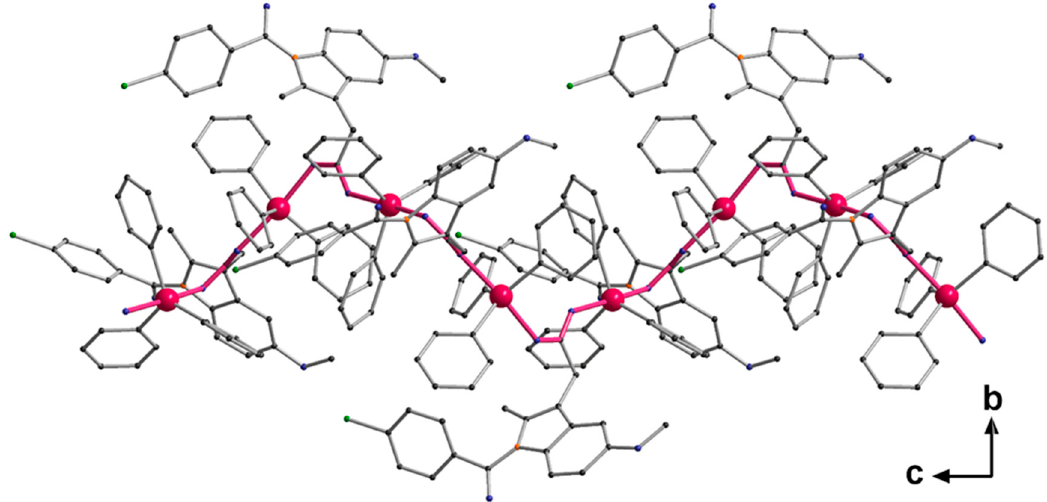
Figure 3. Helical chain structure of [Ph 3 Sn(IND)], propagation via O → Sn coordination. Bonds forming the basis of the helix are highlighted in pink.